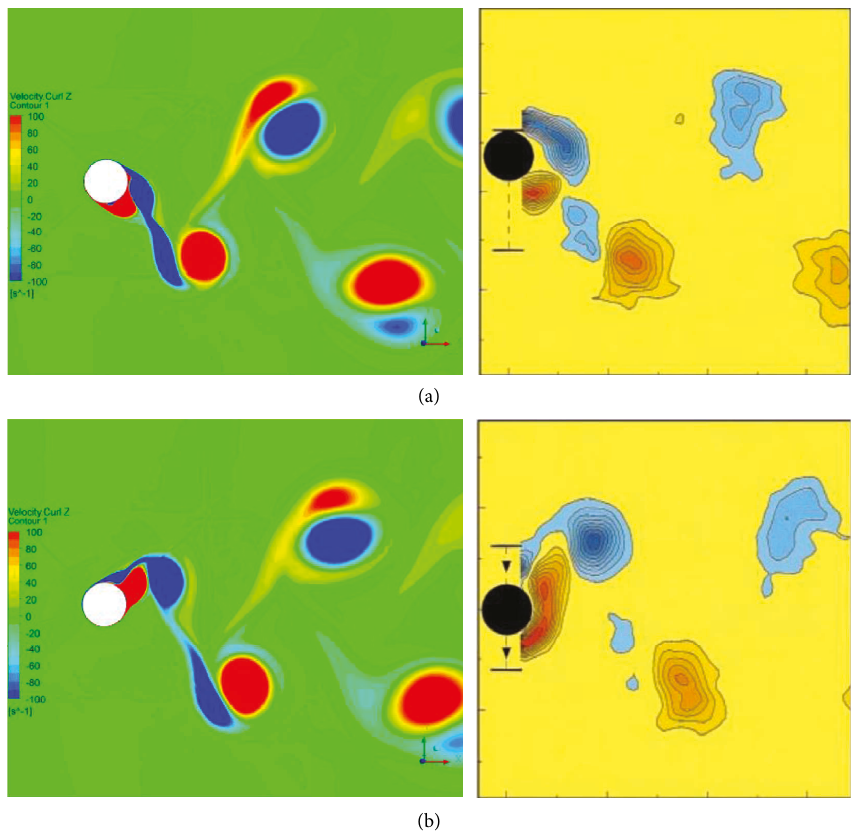
Figure 13: Upper branch showing 2P modes of numerical results at Ur � 4.67 with m ∗ � 2.4 and A ∗ � 0.622 (left) and PIV measurement results with m ∗ � 8.63 and A ∗ � 0.81 by Govardhan and Williamson [26] (right): (a) cylinder highest position; (b) cylinder zero displacement position when traveling